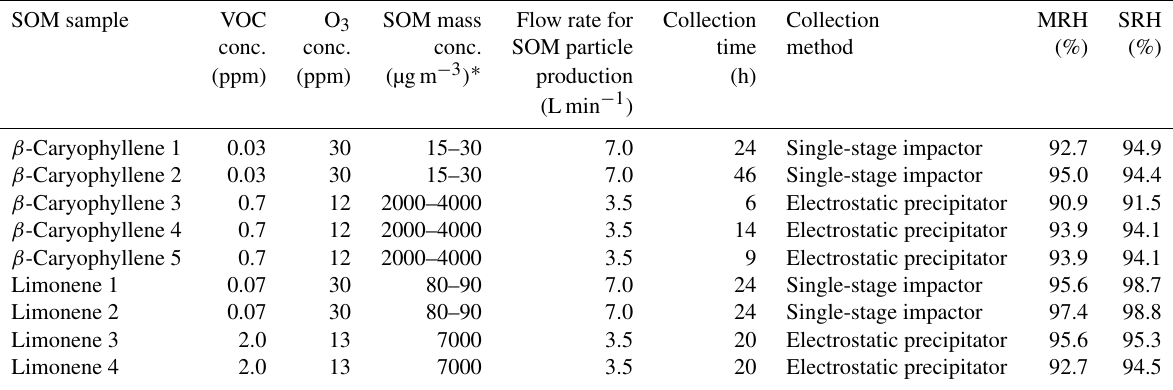
Table 1. Experimental conditions for production and collection of SOM particles by ozonolysis. Included is the measured separation relative humidity (SRH) upon moistening and mixing relative humidity (MRH) upon drying of the collected particles. Particles were collected on hydrophobic substrates using an electrostatic precipitator or single-stage impactor. The uncertainty in the MRH and SRH values is ± 2.0% RH, due to the uncertainty in the RH measurements. SOM sample VOC O 3 SOM mass Flow rate for Collection Collection MRH SRH conc. conc. conc. SOM particle time method